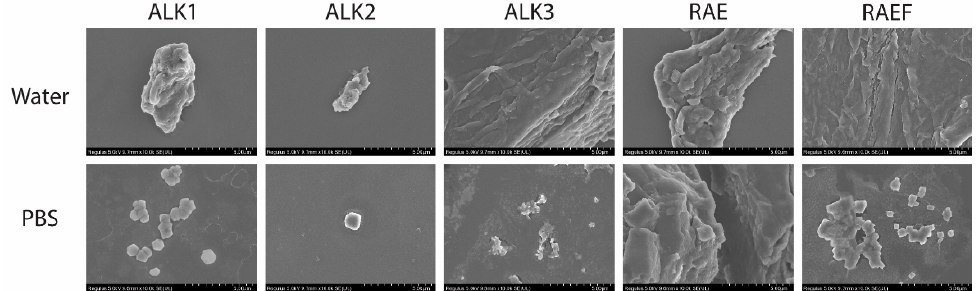
Figure 1. Peptides were prepared using film dehydration and then resuspended in either water or PBS. Samples were dried and sputter-coated with platinum before conducting SEM. All images were captured at a magnification of 10.0 k, and scale bars represent 5 µ m.